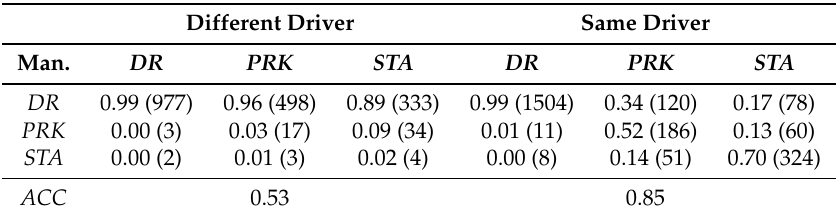
Table 19. Confusion matrices when the system is used by a driver who is different or the same as the one for which the system was